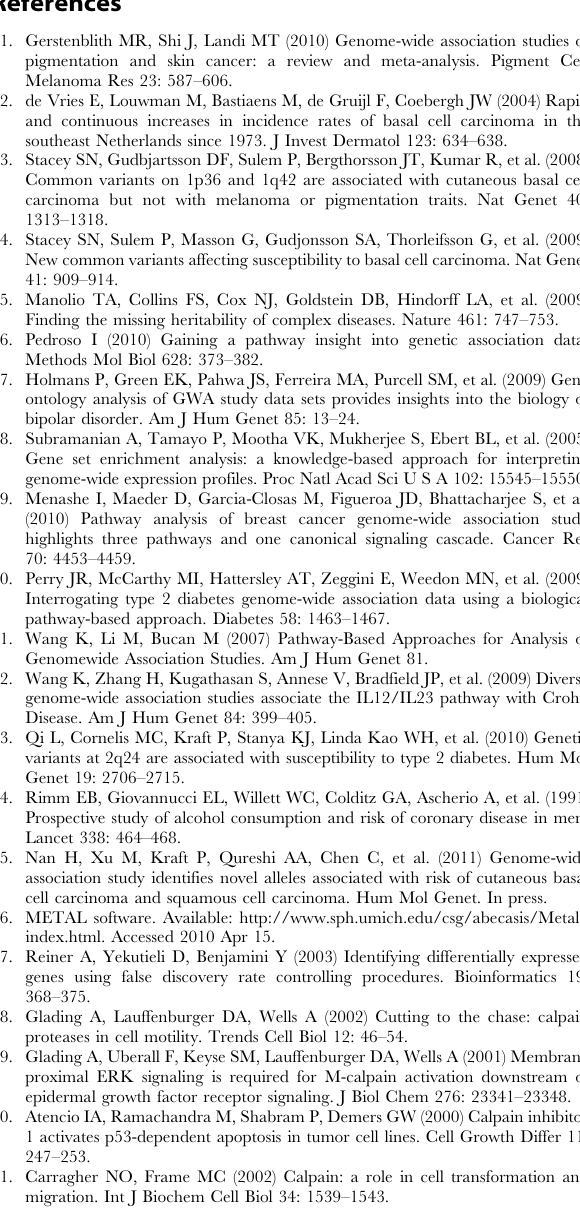
Table S2 The representative SNP information for the two positive control pathways. Table S3 Association results for the 174 KEGG path- ways and 205 BioCarta pathways. (a) Association results for the 174 KEGG pathways; (b) Association results for the 205 BioCarta pathways. Table S4 The representative SNP information for the four pathways with significant enrichment in the BCC GWAS. (XLS) Methods S1 Description of the GWAS on